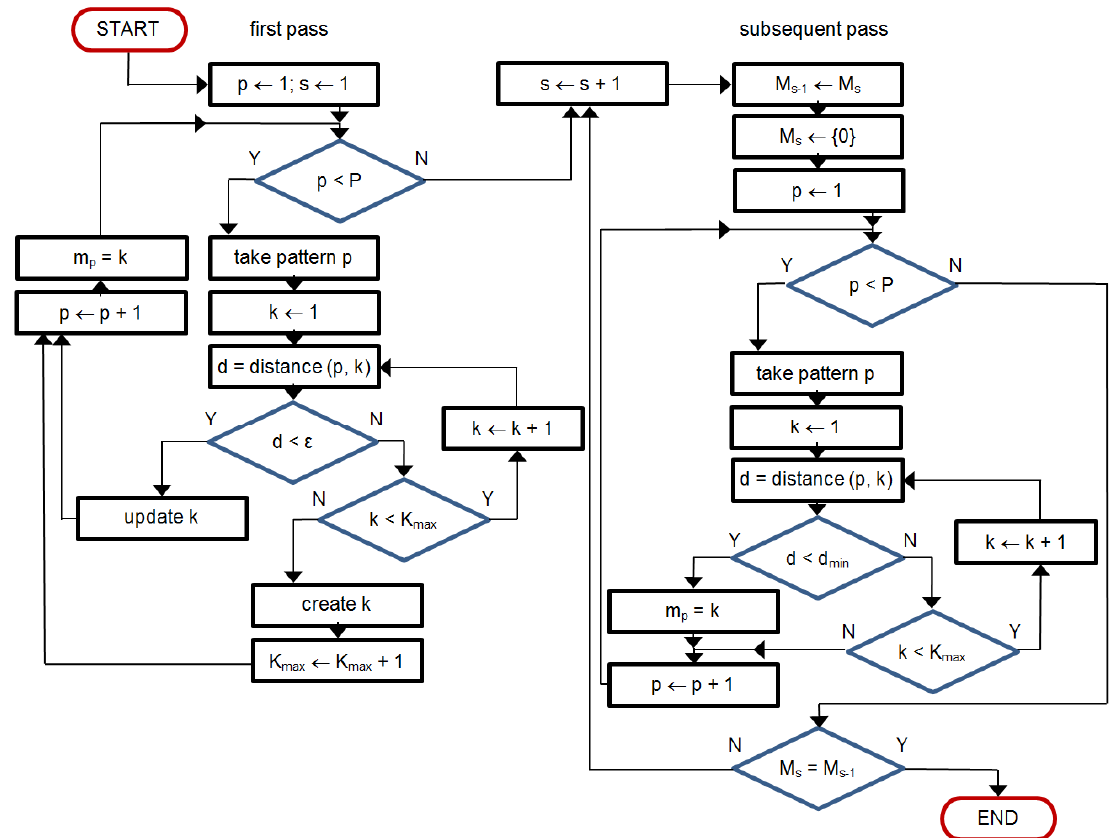
Figure 3. Multipass classification scheme (simplified).